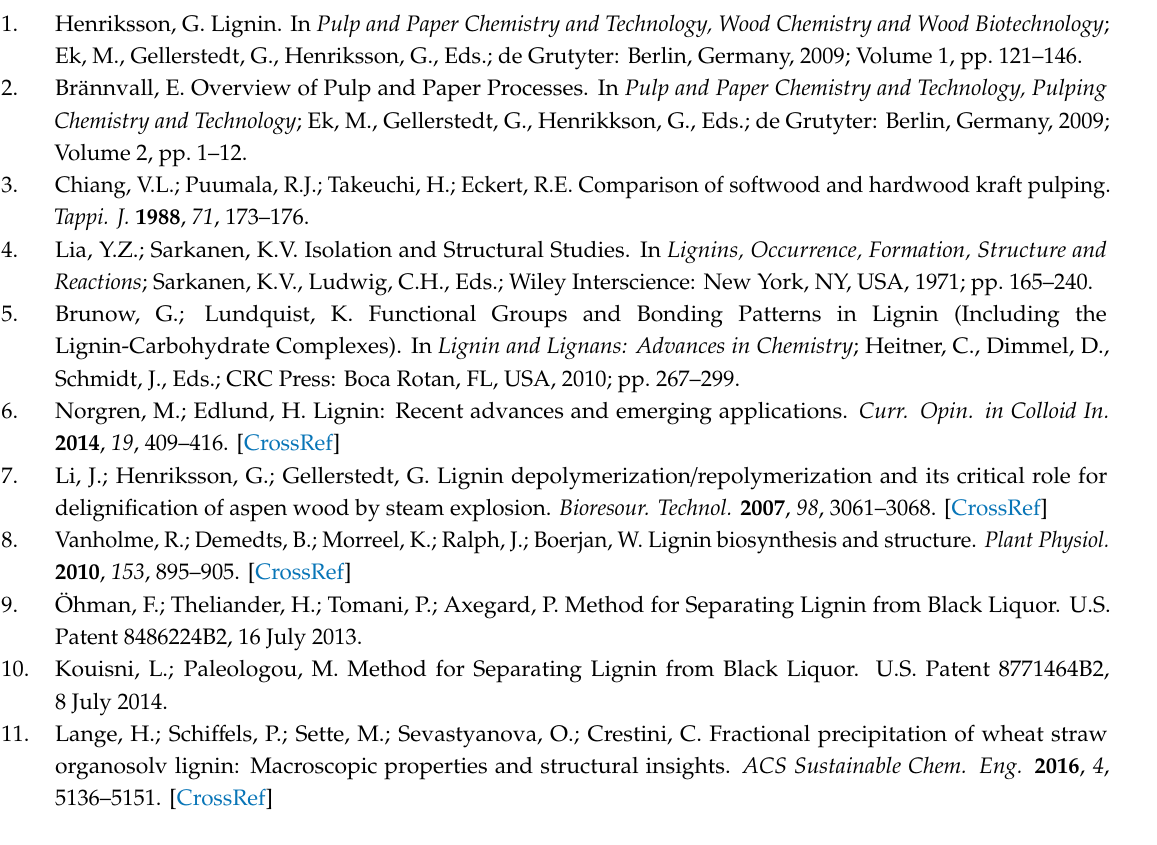
Supplementary Materials: The following are available online, Figure S1: SEC molecular weight distribution profiles of the heat-treated GL400S (a), GL400M (b), and GL400L series (c). The samples were subjected to heat treatment at temperatures of 100–220 ◦ C for 1